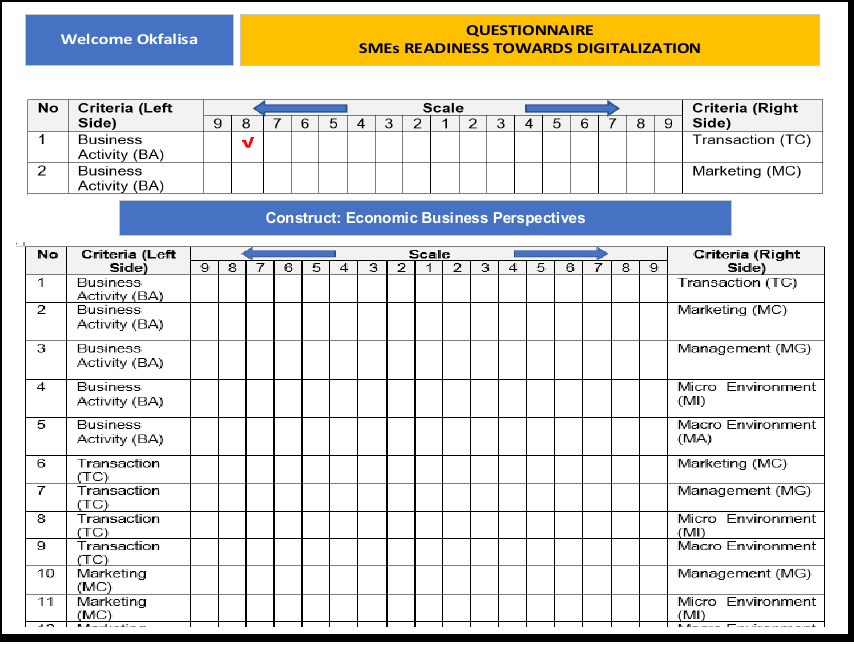
Fig. 6. Interface designed of DSS-SMEsReadiness for questionnaire page